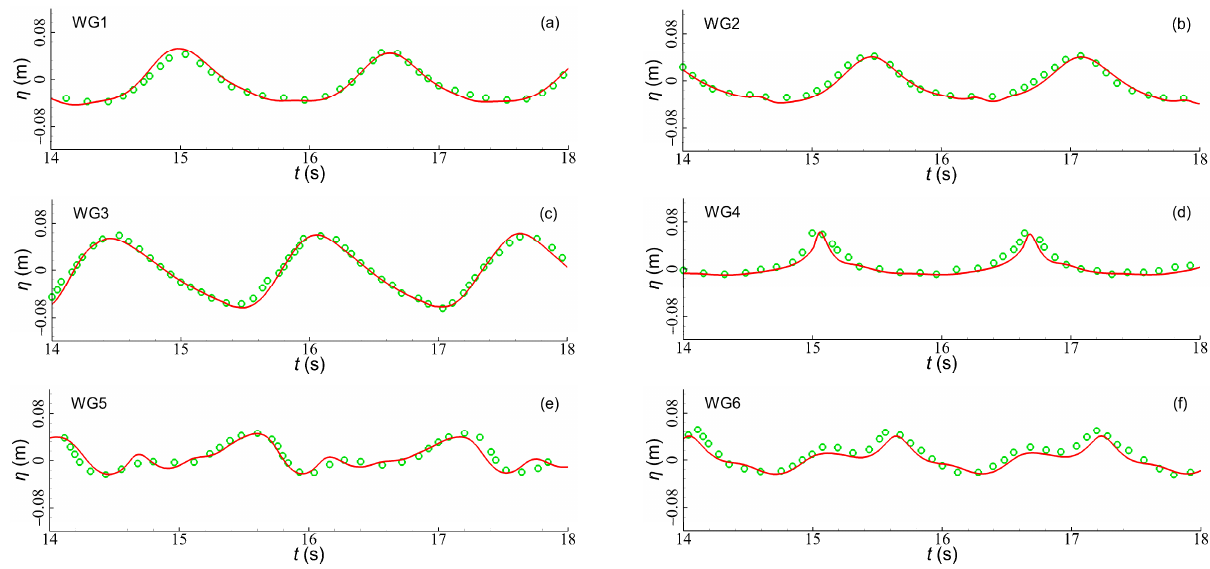
Figure 3. Computational layout for the regular waves transforming over the submerged permea- ble breakwater.